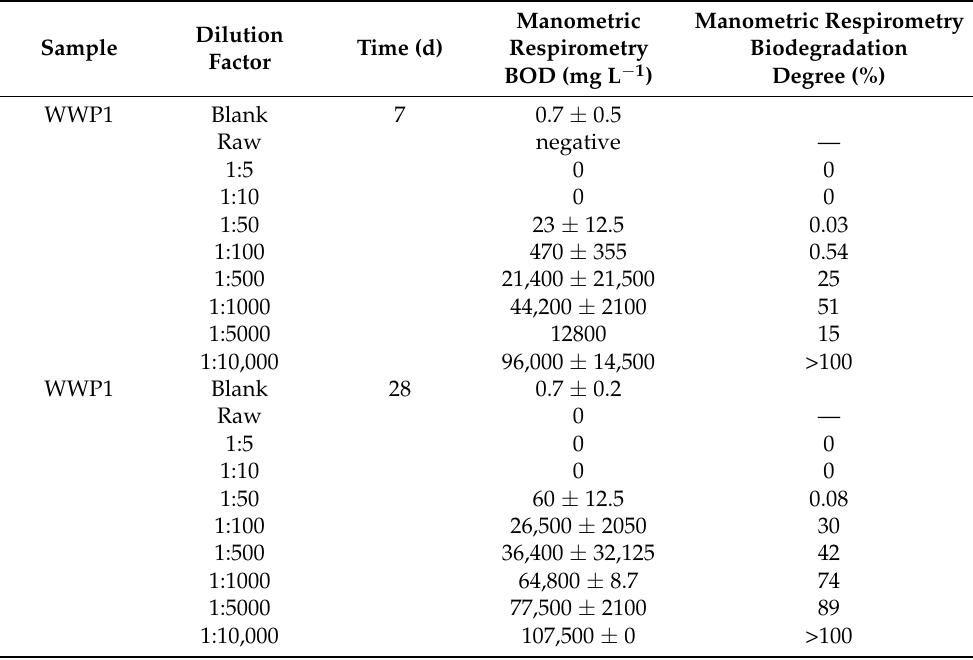
Table 3. The sample, dilution factor, and BOD values and the calculated degrees of biodegradation of the WWP1 sample measured with the manometric respirometry method.